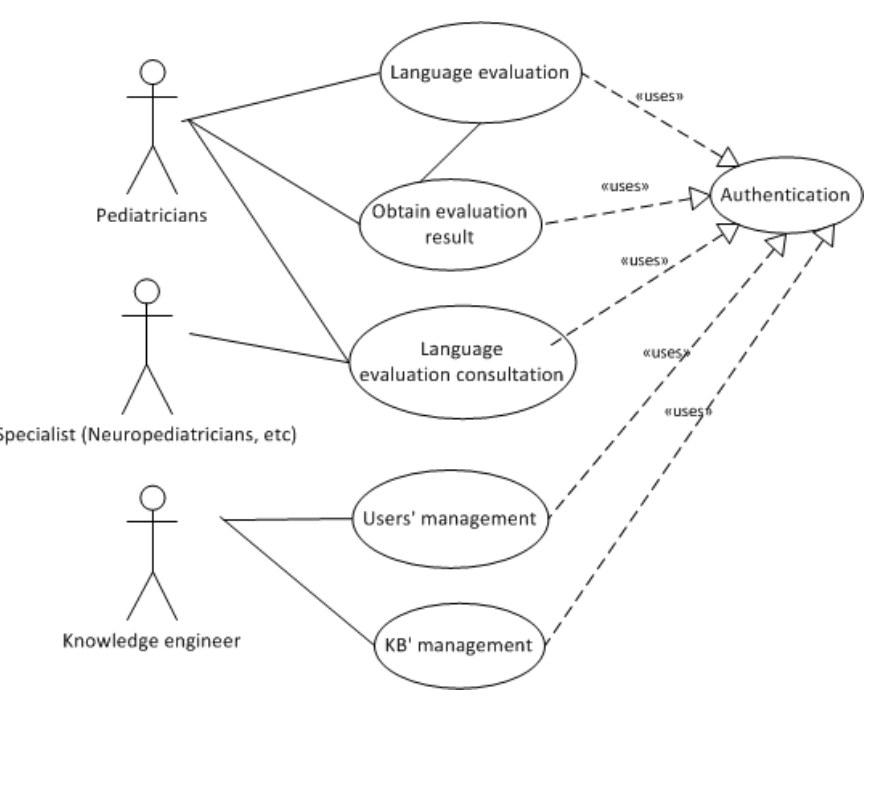
Figure 2. Pegasus general use case